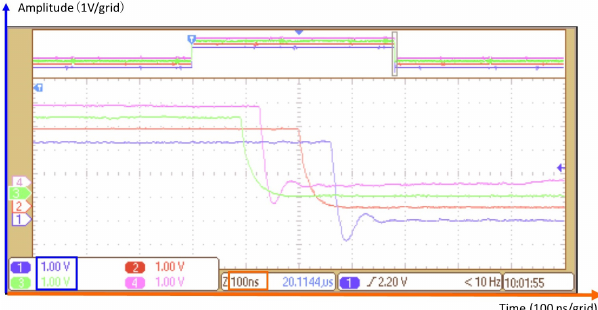
Figure 9. Synchronization precision test results of acquisition sta-